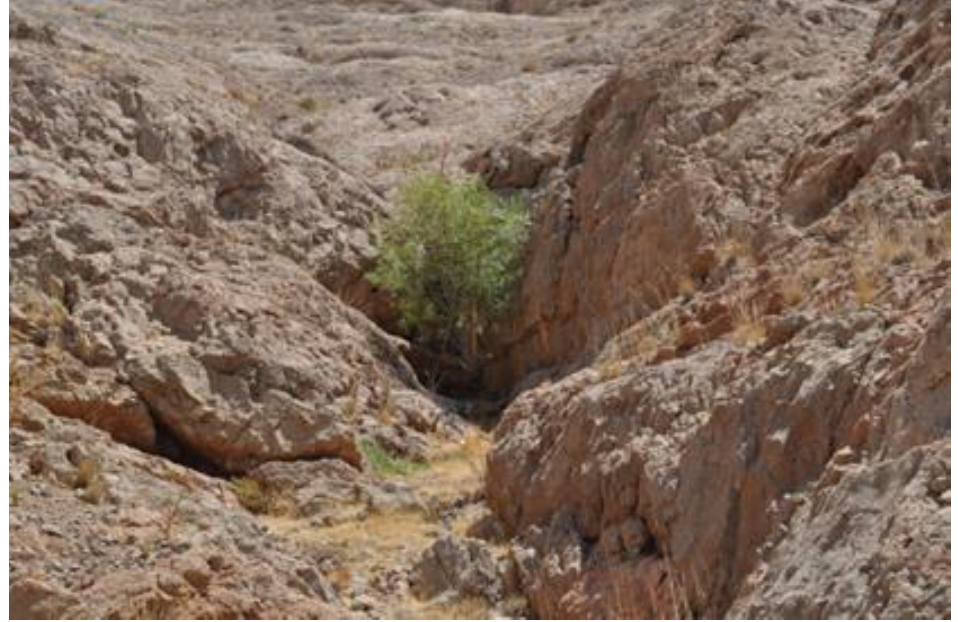
Figure 4. Kuh-e-Donbeh. General view of Site